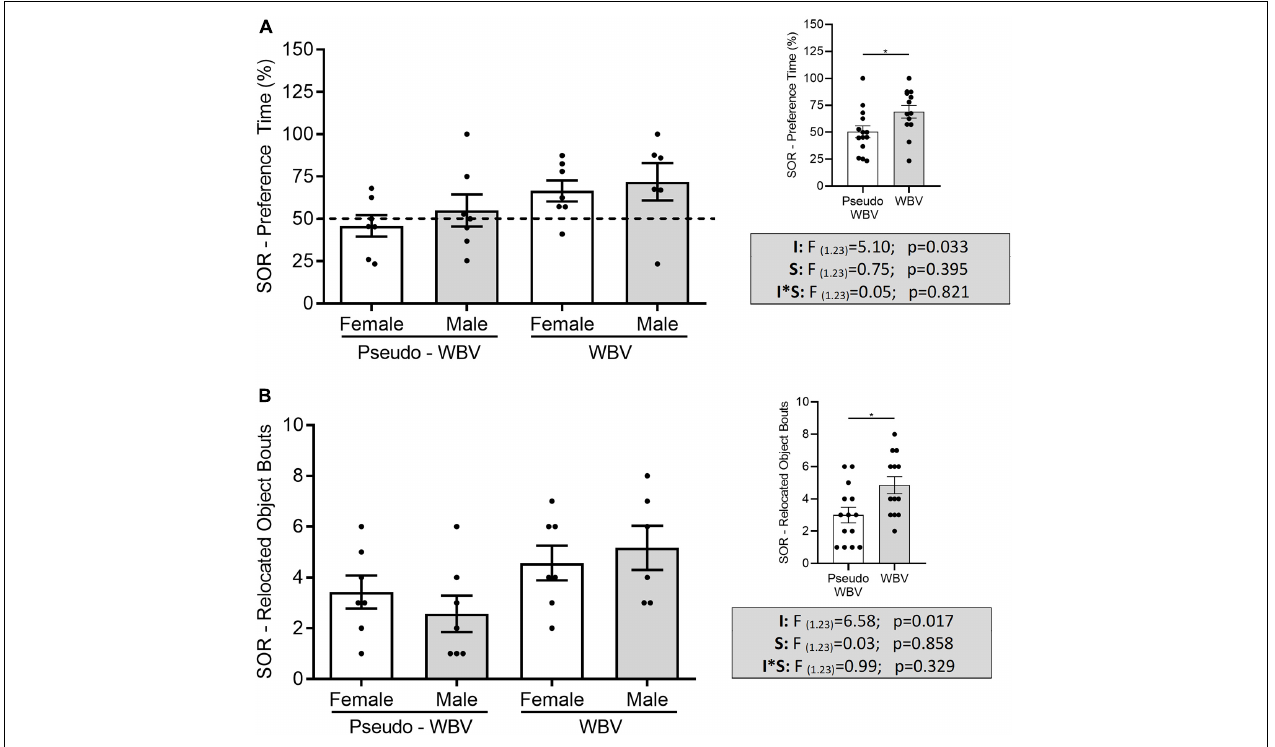
FIGURE 4 | Effects of whole body vibration on spatial memory in the spatial object relocation test. Preference time (A) and relocated object bouts (B) were significantly increased in vibration treated groups compared with control groups. Two-way ANOVA was used for analyzing these results. Pseudo whole body vibration ( n = 14, 7 females and 7 males) and whole body vibration ( n = 13, 7 females and 6 males). Dotted line: reference line of 50% for random exploration. F, F statistical value; I, main effect of intervention (vibration/pseudo vibration); S, main effect of sex (male/female); I*S, interaction effect of intervention and sex. Data are depicted as mean ± SEM. * p <